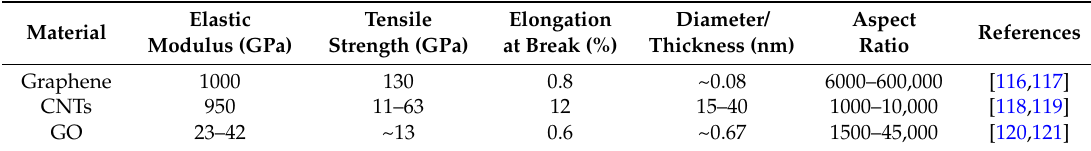
Table 2. Mechanical properties of graphene, CNTs and GO (adapted from